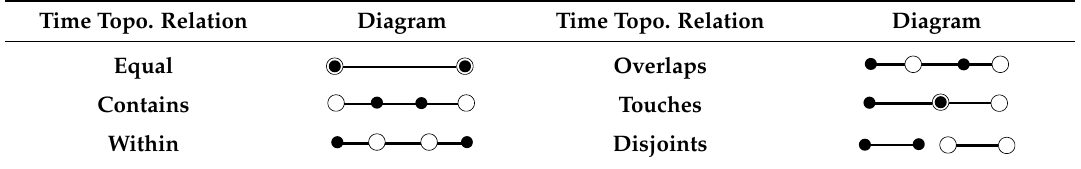
Table 3. The topology relations among time intervals. Time Topo. Relation Diagram Overlaps